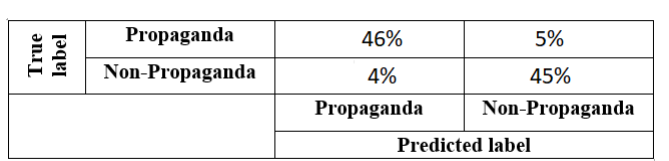
Figure 7. Confusion matrix of propaganda detection in hidden mixed-code text.